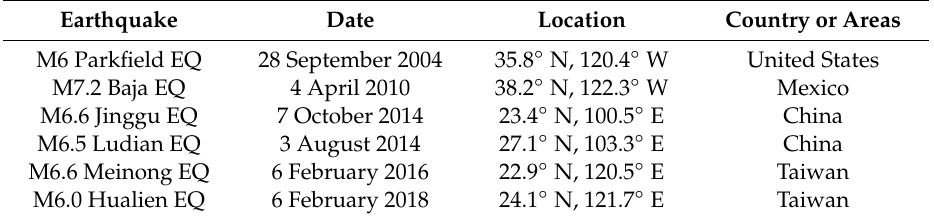
Table 2. Occurrence time and locations of the six selected earthquakes utilized in this